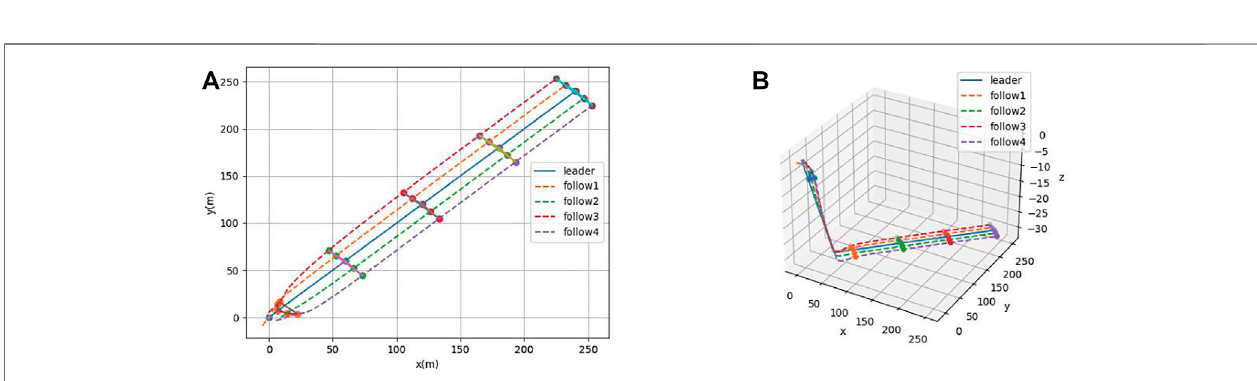
FIGURE 7 | (A) Formation process the heterogeneous AUV group under communication delay (2-D). (B) Formation process the heterogeneous AUV group under communication delay (3-D).